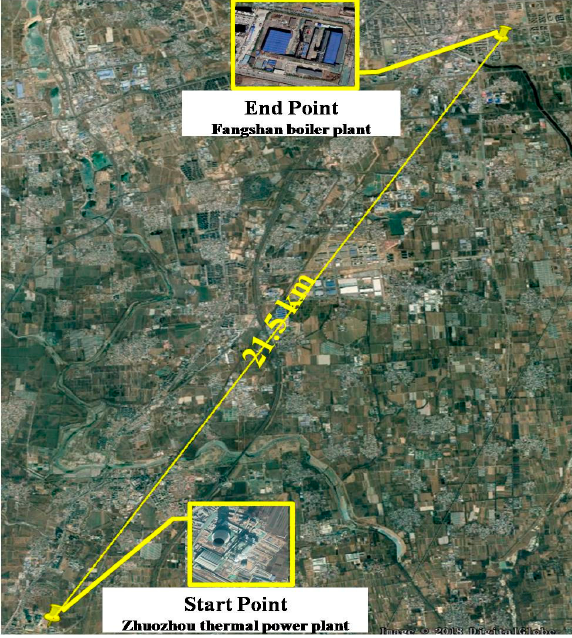
Figure 1. The location of the start point and end point of the ZF heating engineering project.